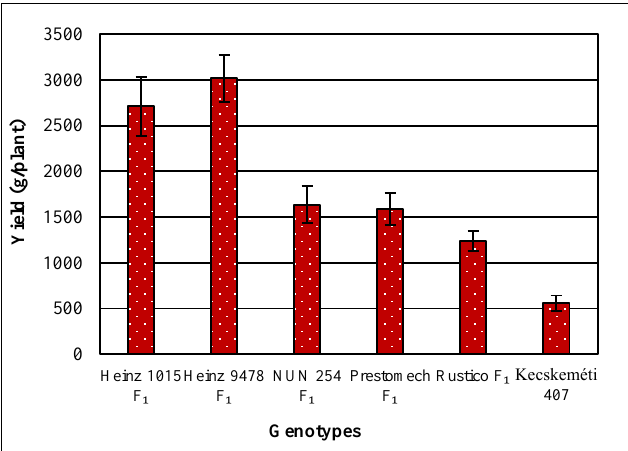
Figure 2. The yield of the evaluated genotypes.